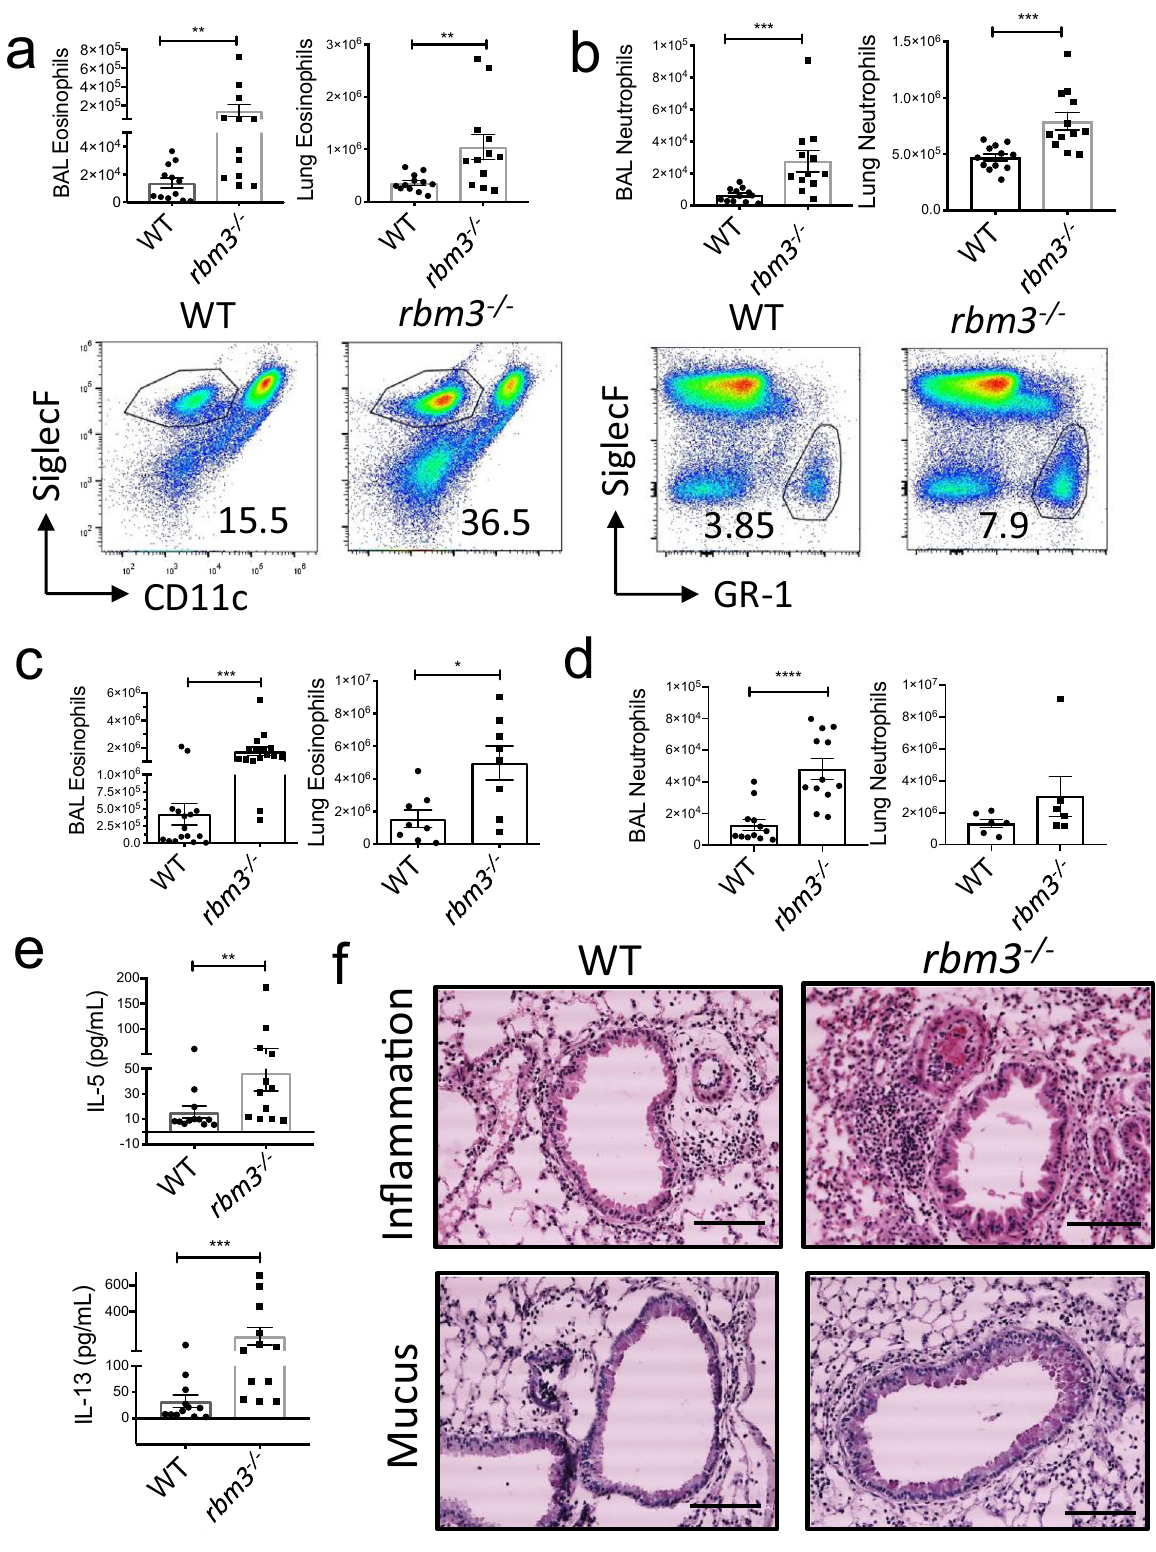
(Fig. 4a – c). BAL and lung eosinophils were also signi fi cantly increased in the double knock-out mice compared to controls (Fig. 4d). Overall, these results show a suppressive effect of RBM3 in type 2 lung in fl ammation and ILC activation, even in the absence of adaptive